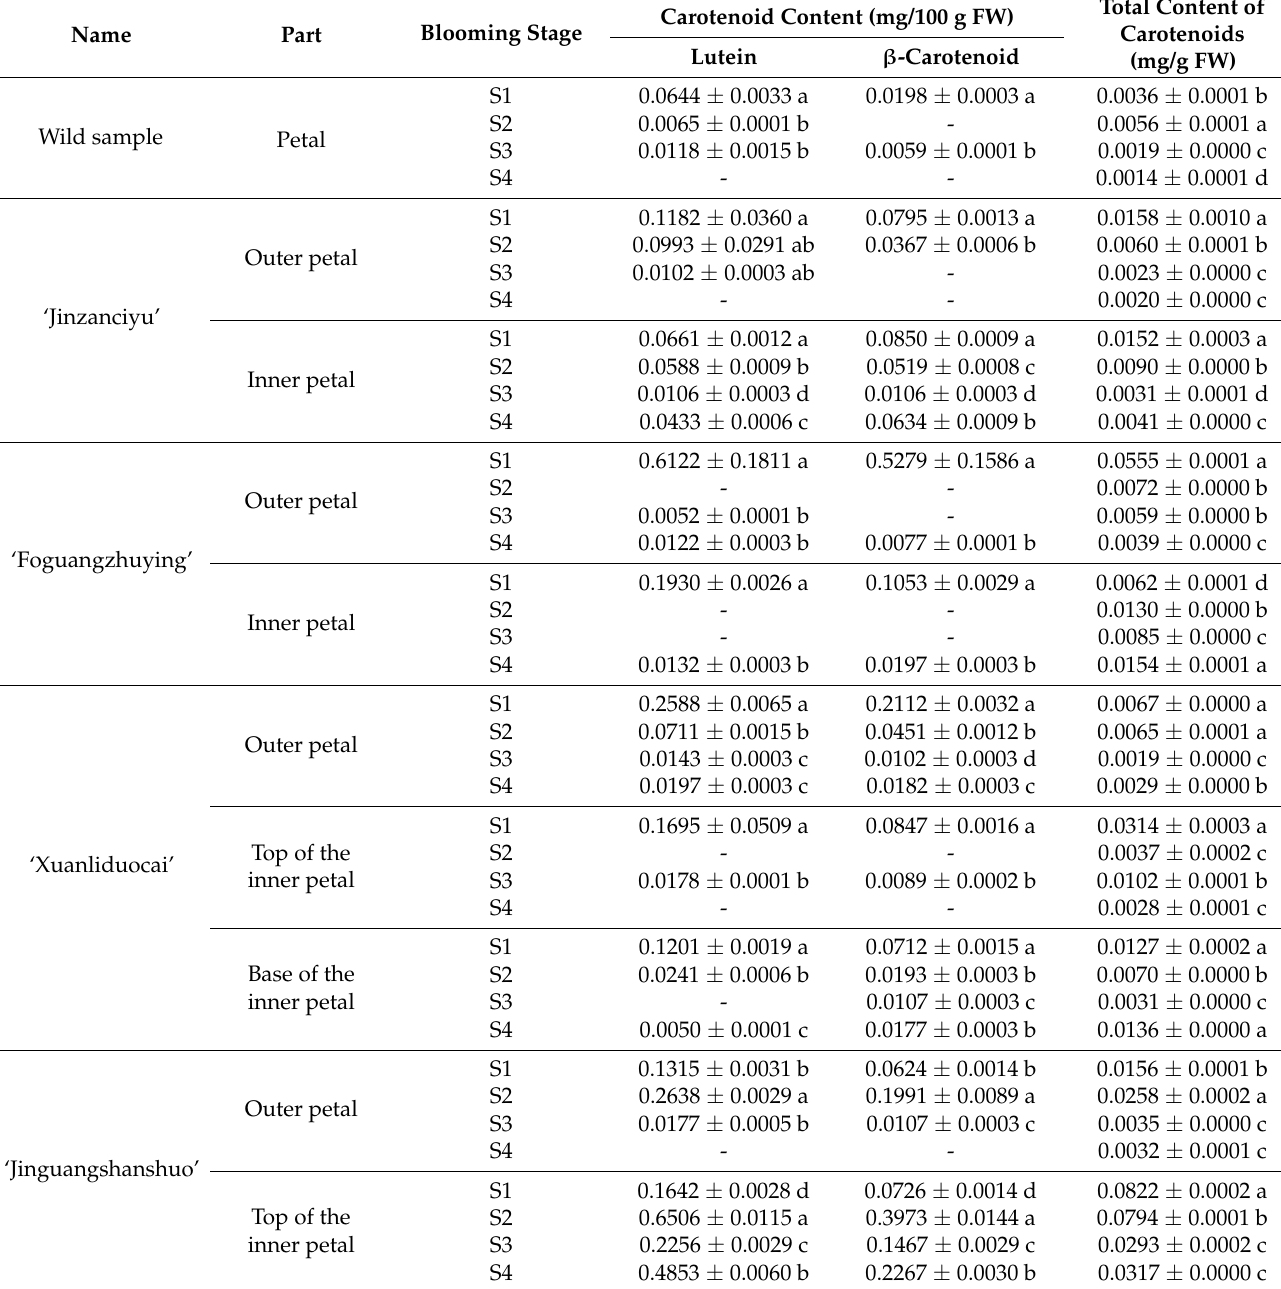
Table 3. Composition and content of carotenoids in herbaceous peony